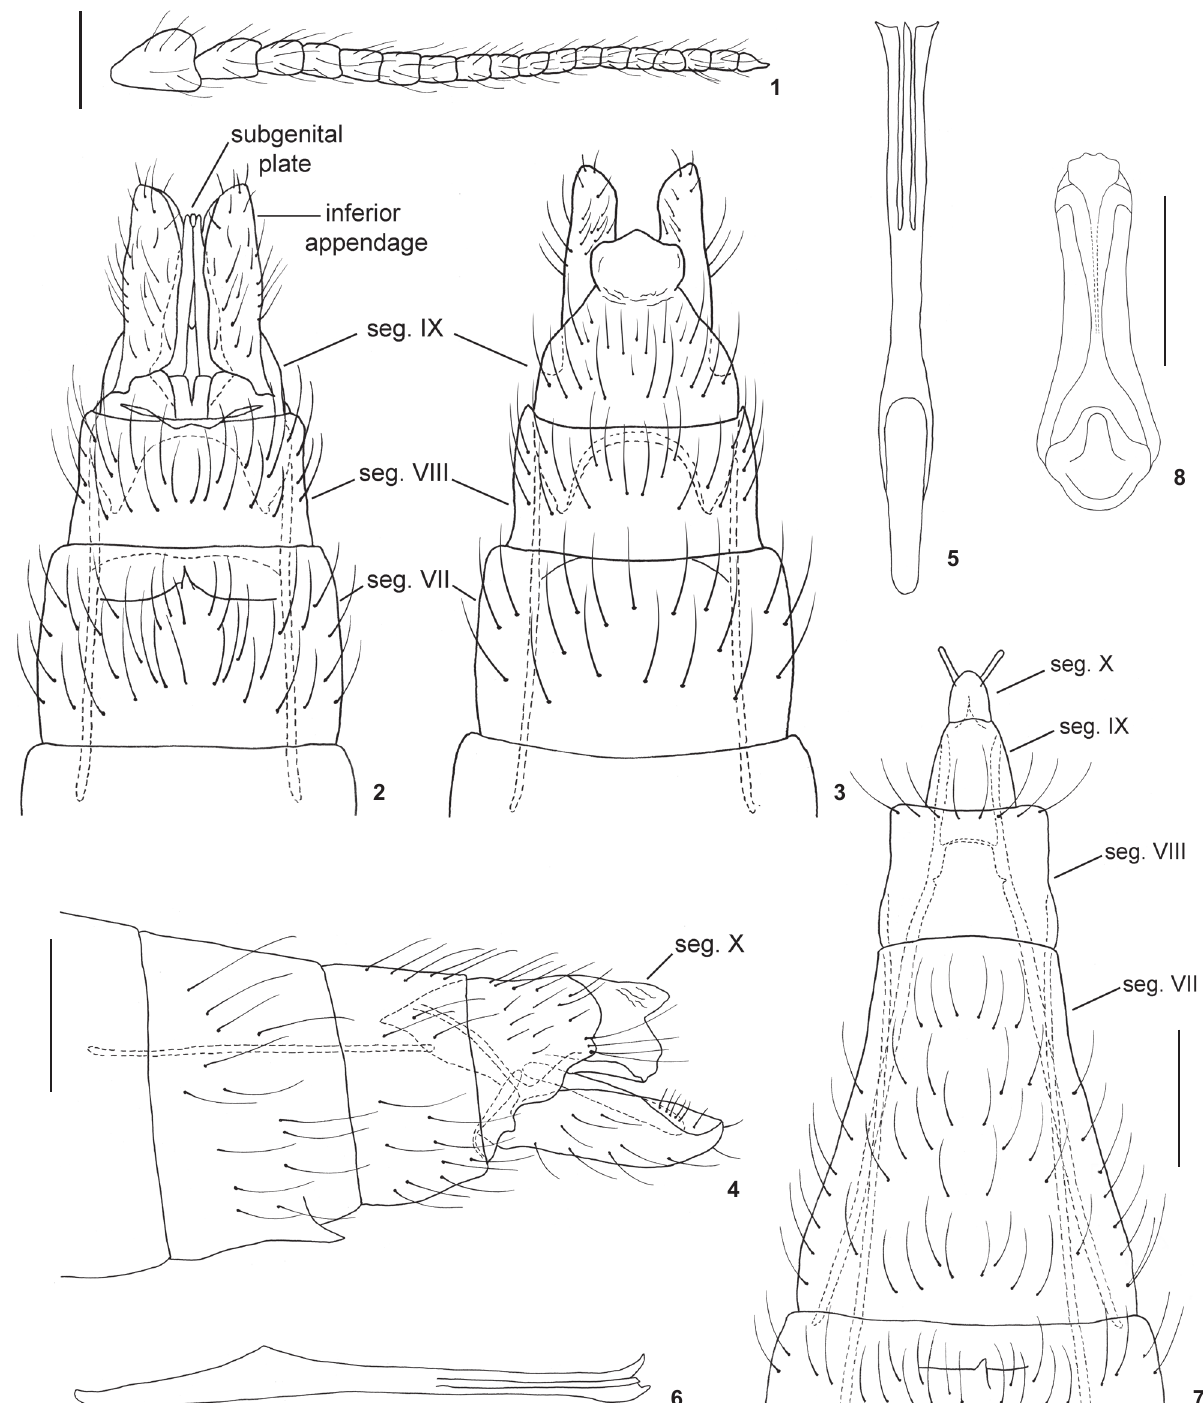
Figures 1-8. Flintiella carajas sp. nov. : (1) male antenna, lateral view; (2) male genitalia, ventral view; (3) male genitalia, dorsal view; (4) male genitalia, lateral view; (5) phallus, dorsal view; (6) phallus, lateral view; (7) female genitalia, ventral view; (8) bursa copulatrix, ventral view. Scale bars: 0.1